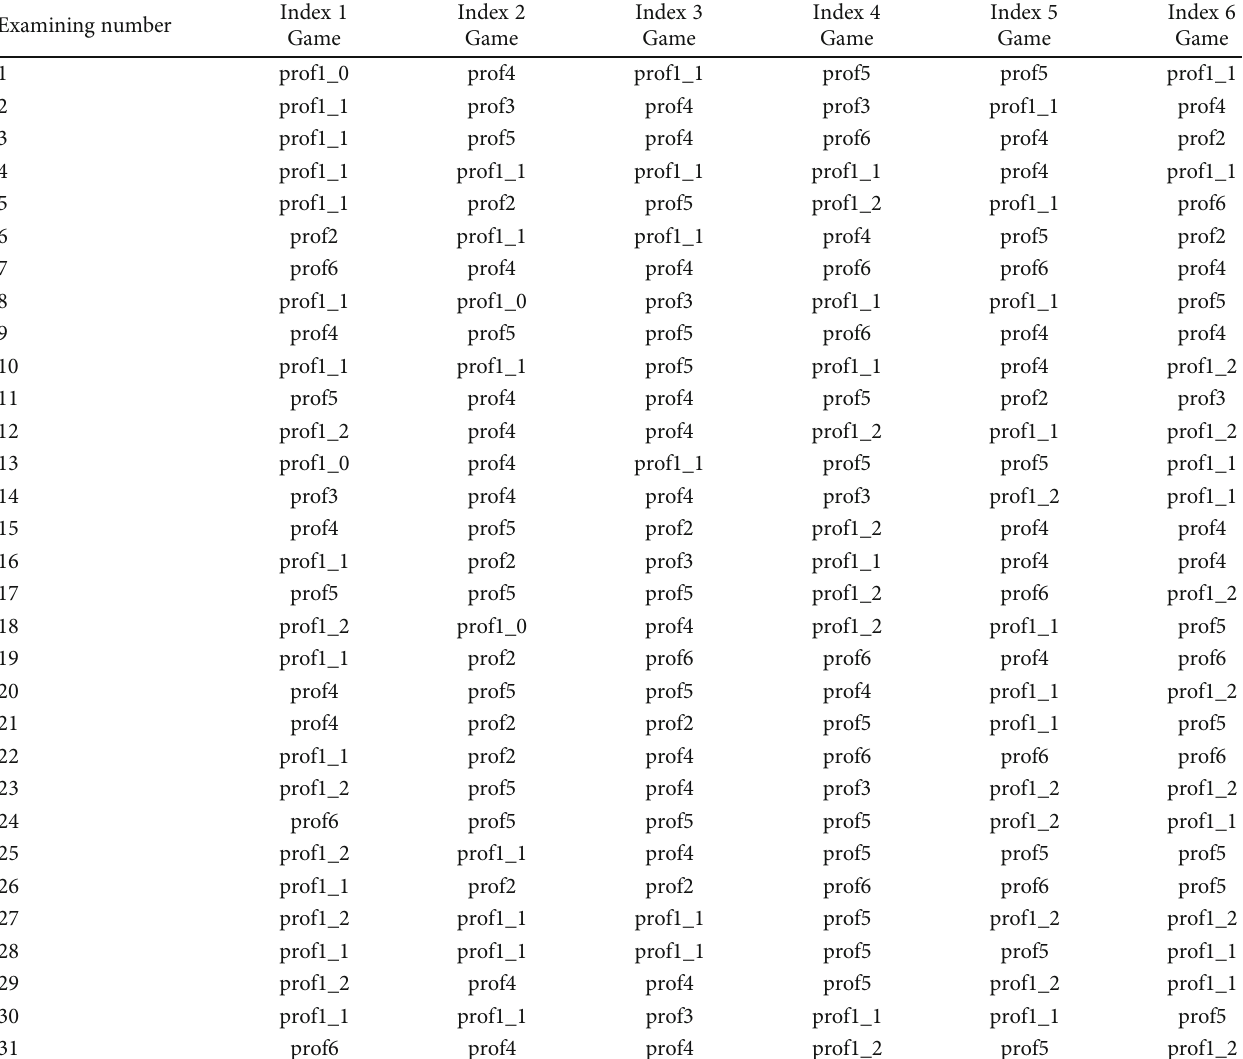
Table 4: The table shows the distinguished games in which the involvement index was